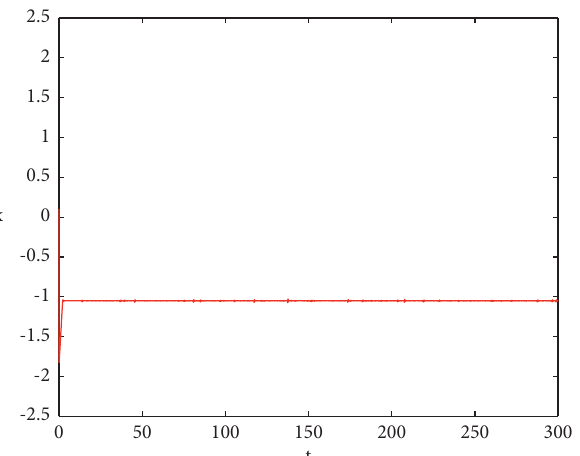
Figure 3: Temporal evolution of membrane potential x in FHN neuron system after the addition of flux-controlled